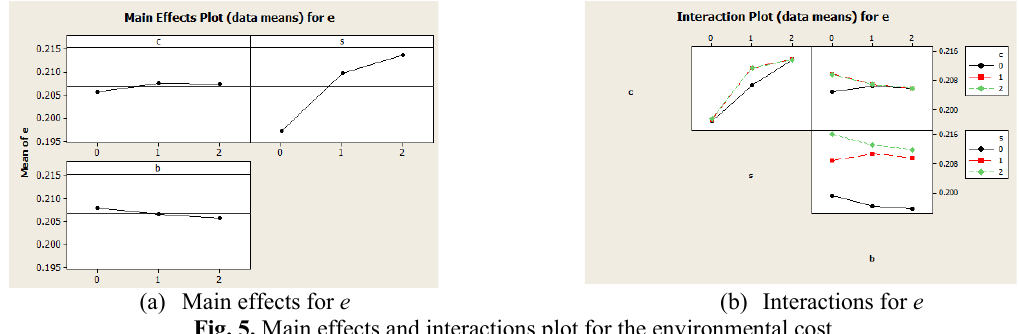
(a) Main effects for e (b) Interactions for e Fig. 5. Main effects and interactions plot for the environmental cost